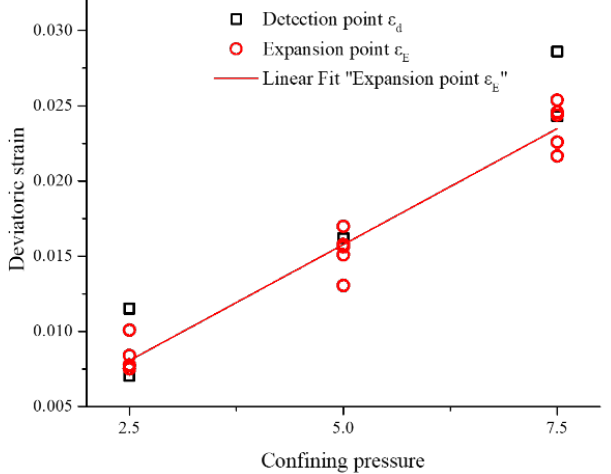
Figure 20. Deviatoric strain value ε d and ε E versus confining pressure.